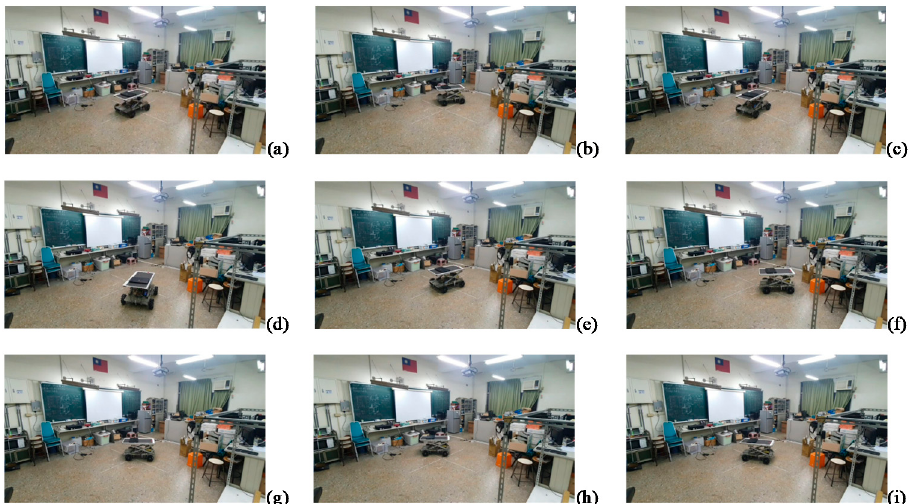
Figure 17. The captured pictures of the OMWAGV moving diagonally without RLS estimation and compensation. ( a ) Starting position, ( b ) forward at an angle of 45 degrees to the left, ( c ) return to the starting position, ( d ) backward at an angle of 45 degrees to the right, ( e ) back to the starting position, ( f ) forward at an angle of 45 degrees to the right, ( g ) return to the starting position, ( h ) backward at an angle of 45 degrees to the left, ( i ) return to the starting position.